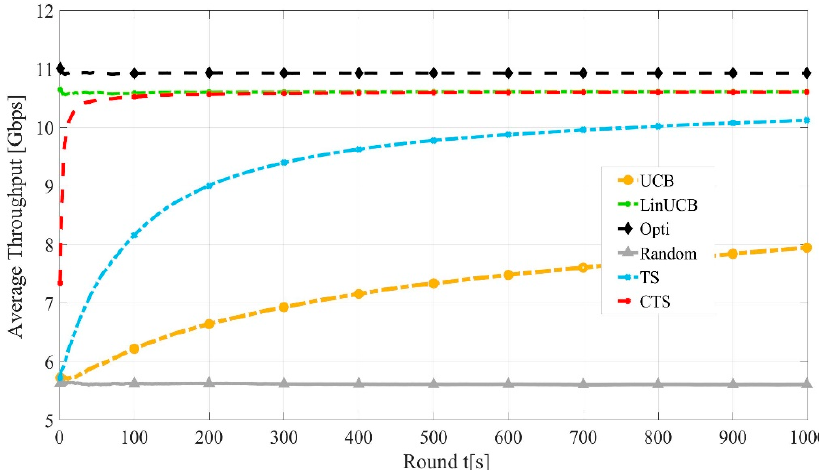
Figure 5. Convergence rates of LinUCB, CTS, TS, and CTS algorithms.